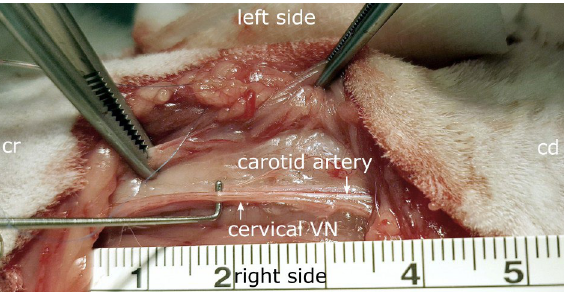
Figure 1. Surgical window showing the dissection of the right vagus nerve (VN) at the cervical level for instrumentation with cuff electrodes in a rabbit. The carotid artery runs parallelly to the cervical VN. Cr cranial, cd